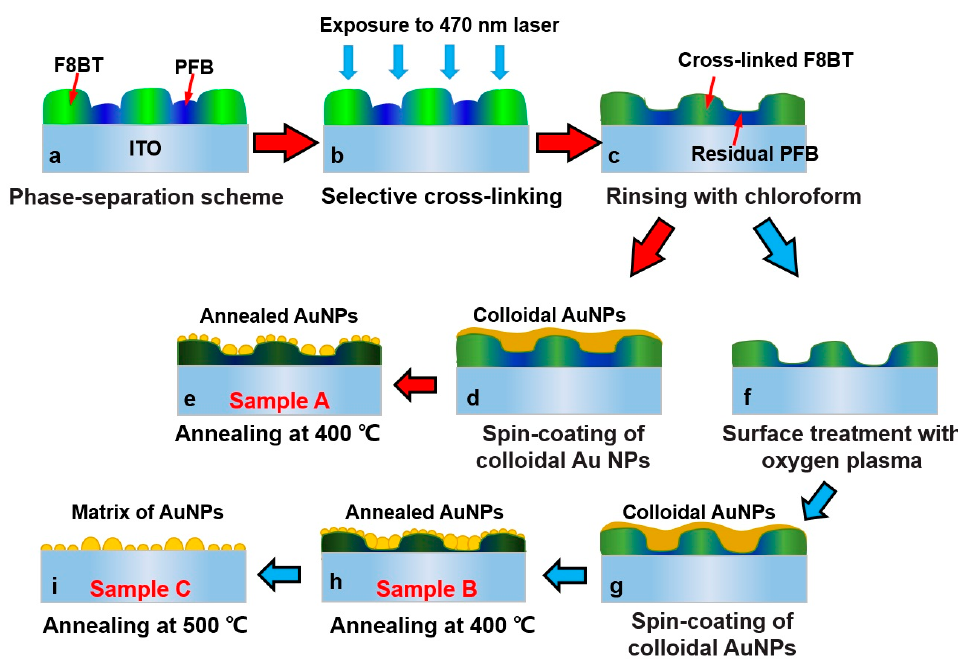
Figure 1. Fabrication procedures: ( a ) spin-coating of the blend film to form the phase-separation scheme; ( b ) exposure of the blend film to the 470-nm laser beam to achieve selective cross-linking of the F8BT molecules; ( c ) rinsing using chloroform; ( d ) spin-coating of colloidal gold nanoparticles; ( e ) annealing at 400 °C to produce Sample A; ( f ) surface treatment using oxygen plasma; ( g ) spin-coating of colloidal gold nanoparticles; ( h ) annealing at 400 °C to produce Sample B; ( i ) further annealing at 500 °C to produce Sample C.